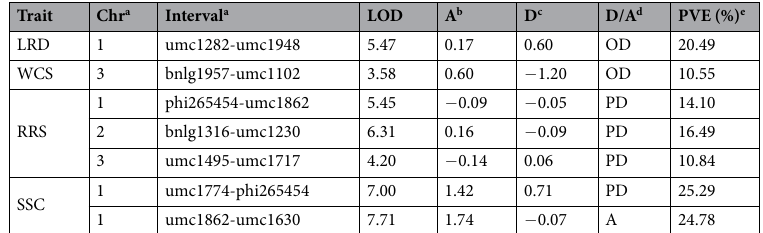
Table 4. QTLs for the four chilling tolerance traits resolved using composite interval mapping in the F 2:3 population. a Chromosome number and marker intervals; b Additive effects - the positive values indicate the alleles from Mei C have the effect on increasing the trait value; c Dominance effects - positive values indicate that heterozygotes have higher phenotypic values than the respective means of the two homozygotes; d Gene action - OD = overdominance, PD = partial dominance, and A = additive; e PVE = phenotypic variation explained by the